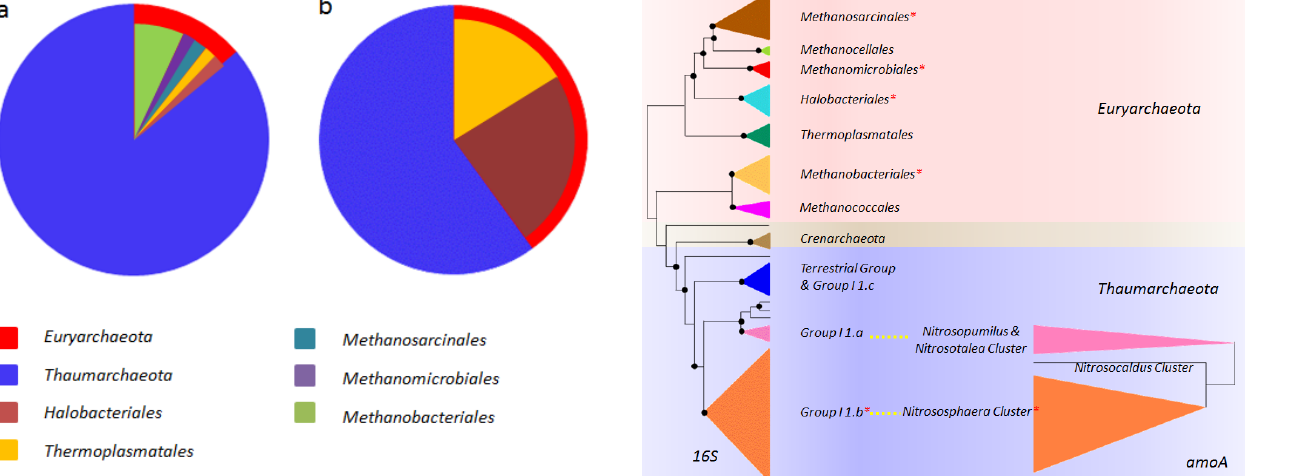
Figure 2. Phylogeny of Euryarchaeota and predicted ammonia- oxidizing Thaumarchaeota . Schematic illustration of a collapsed maximum likelihood tree based on the OTU sequences found in Mainz, Germany, in the 16S rRNA gene (left) and archaeal amoA gene (right), as well as basic tree sequences (Table S2). Black dots represent boot strap values > 80%. Red stars indicate where OTUs from airborne archaea (Mainz, Germany) fall. The amoA cluster names are given according to Pester et al. (2012); the figure has been laid out as in Pester et al.